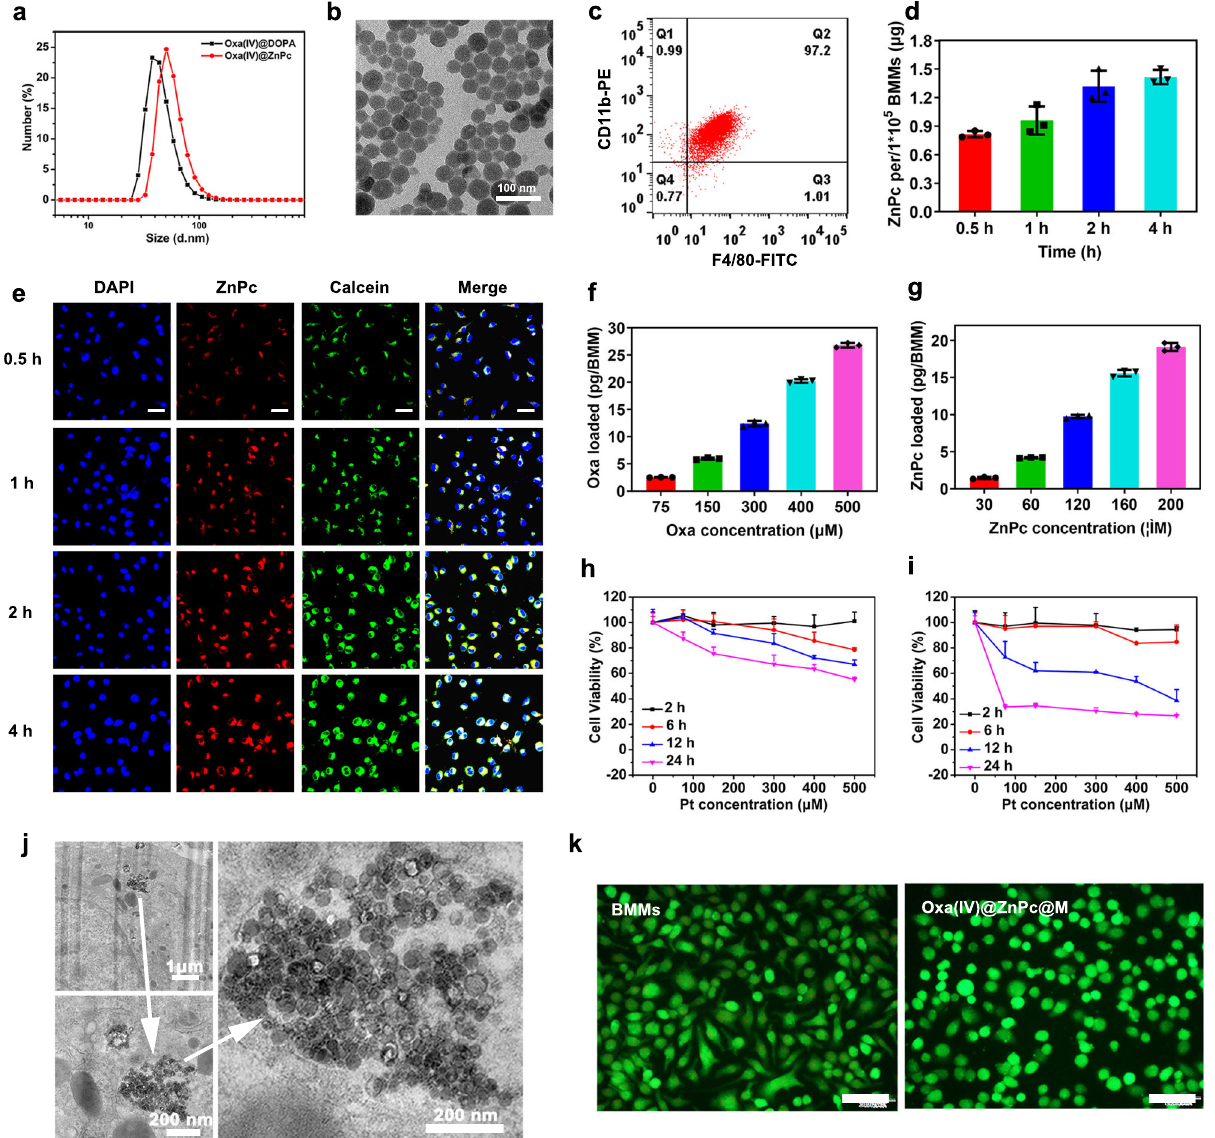
Fig. 2 The preparation and characterization of Oxa(IV)@ZnPc and Oxa(IV)@ZnPc@M. a Average diameters of Oxa(IV)@DOPA and Oxa(IV)@ZnPc measured by DLS. b TEM image of Oxa(IV)@ZnPc, this experiment was performed three times with similar results. c Flow cytometric analysis of the purity of BMMs cultured in L929-CM doubly stained with F4/80-FITC and CD11b-PE. Cellular uptake by BMMs ( d ) quantitatively determined by fl uorescence spectra ( n = 3 technical replicates, the experiment is representative of three independent experiments) and e observed by CLSM at 0.5, 1, 2, and 4